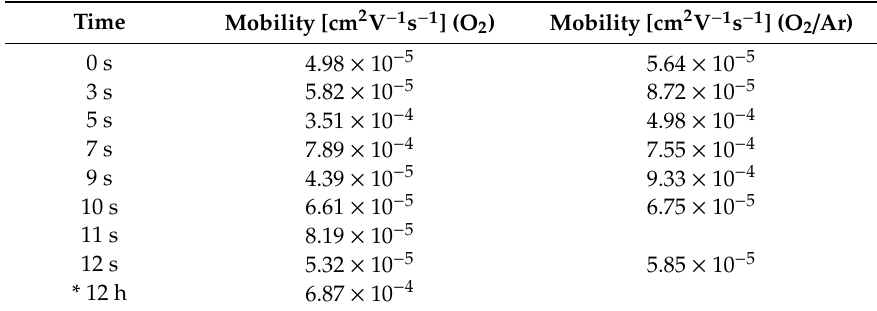
Figure 2. Hole mobility of LiTFSI-doped spiro-OMeTAD with di ff erent exposure time of ( a ) O 2 plasma and ( b ) O 2 / Ar plasma. The symbols indicate the average values with the corresponding standard deviation from 4 samples. The inset shows a schematic architecture of the hole-only device for mobility measurement. Table 1. Average hole-mobility values of LiTFSI-Doped spiro-OMeTAD film exposed to plasma for di ff erent time and stored dark in dry air overnight (12